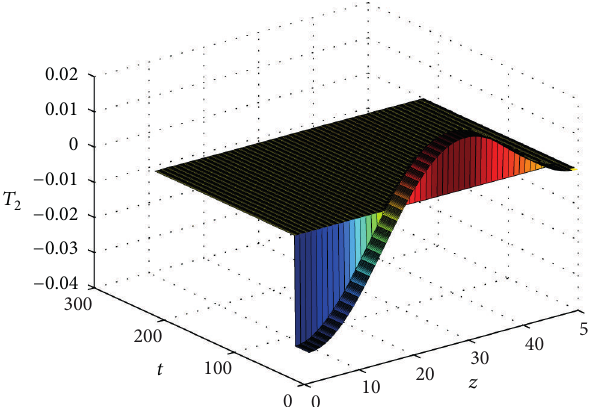
Figure 5: State of the second distributed parameter system under the controller.